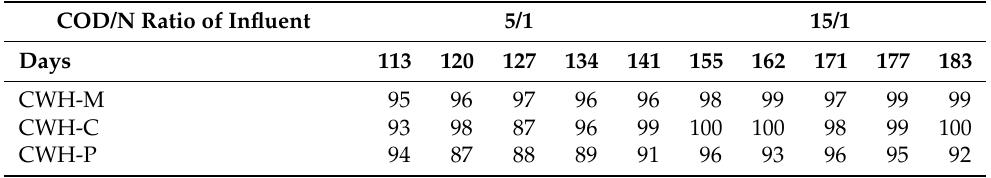
Table A2. Estimated nitrification (%) in the unplanted CWH over the experimental period.